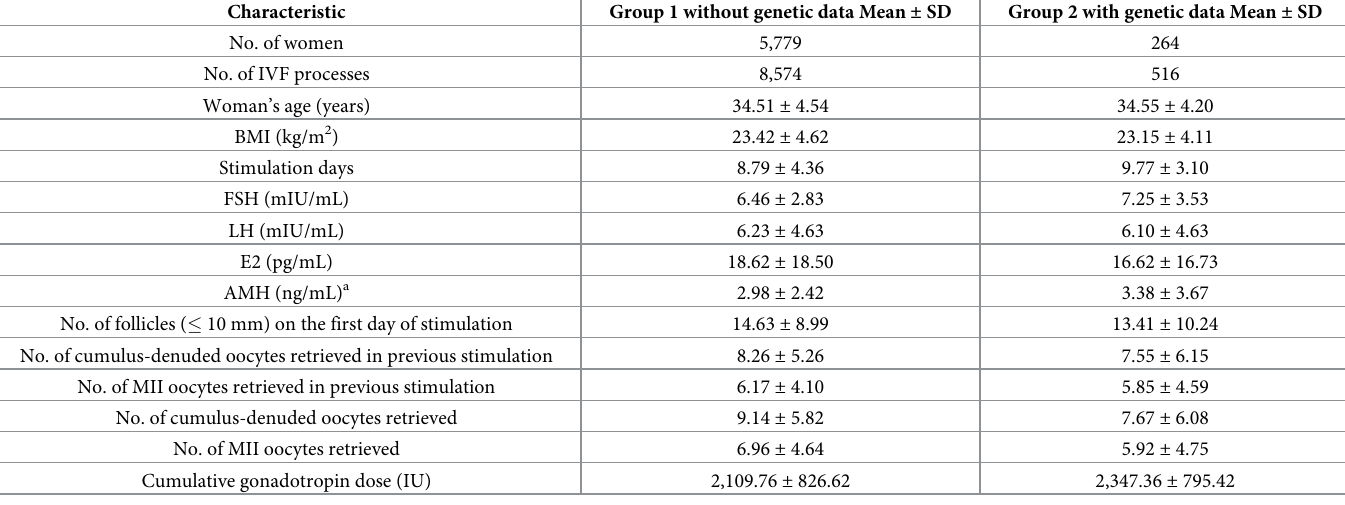
Table 1. Baseline clinical characteristics of study groups. AMH—anti-Mu¨llerian hormone, BMI—body mass index, E2—estradiol, FSH—follicle-stimulating hormone, IU—international unit, IVF—in vitro fertilization, LH—luteinizing hormone.